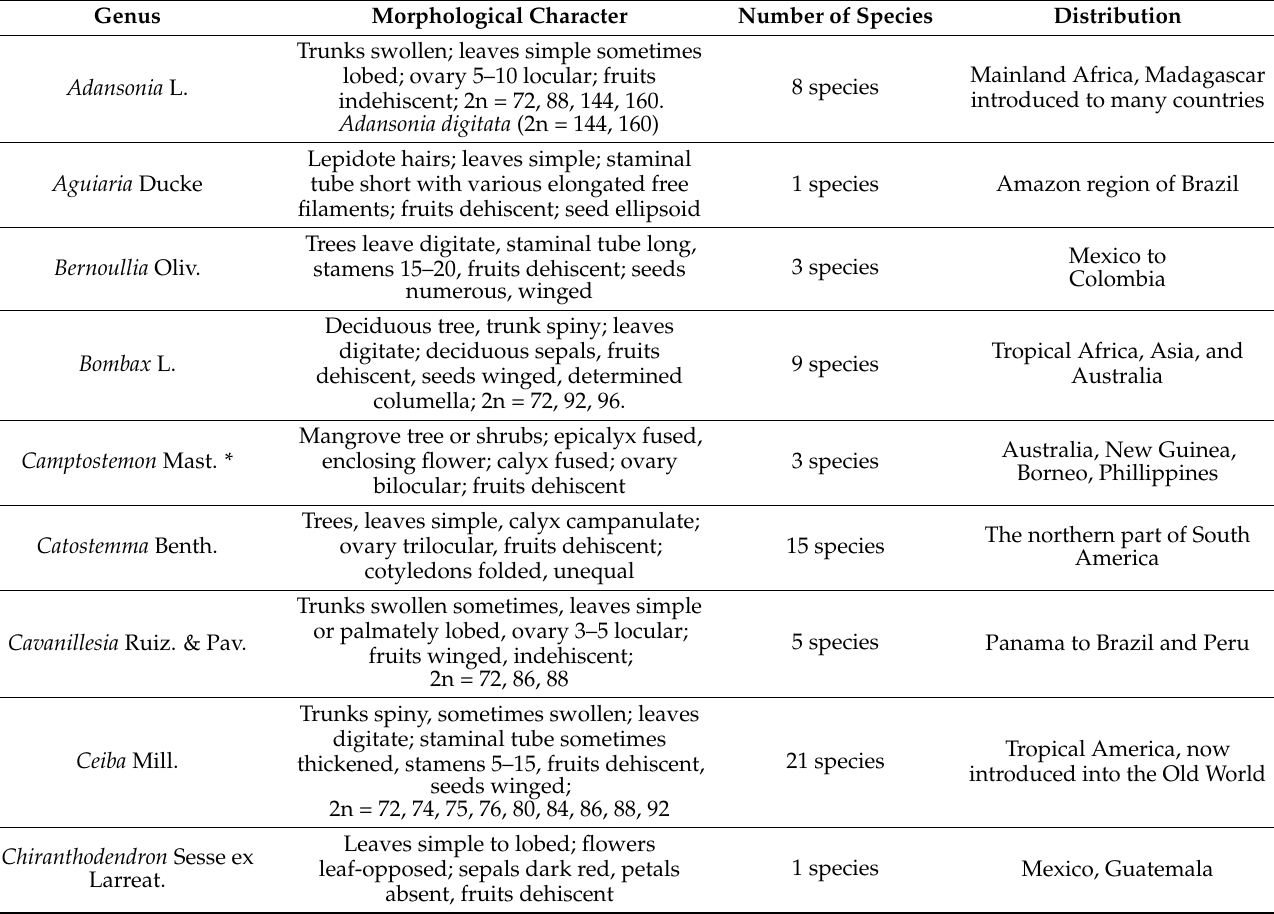
Table 1. General synopsis of the genera under